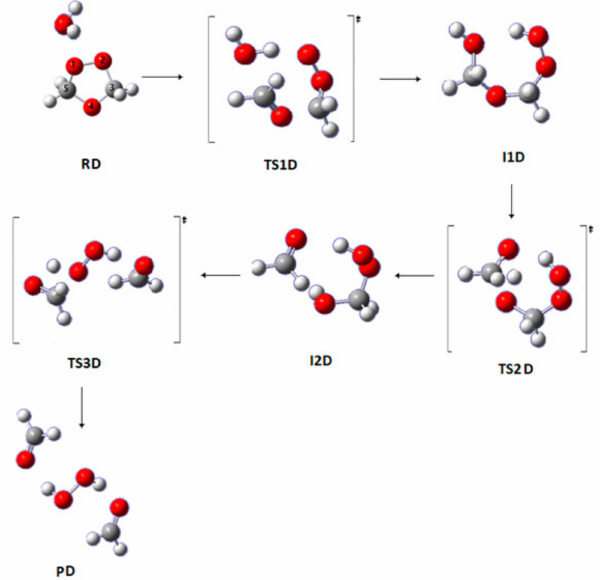
Figure 5. Optimized geometries for the stationary points in Pathway D of the reaction between SOZ and water at the APFD / 6-311 ++ G(3df,3pd) for Pathway